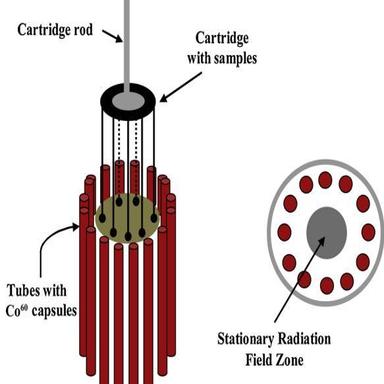
Experimental arrangement for radiation treatment of the chalcogenide glasses.